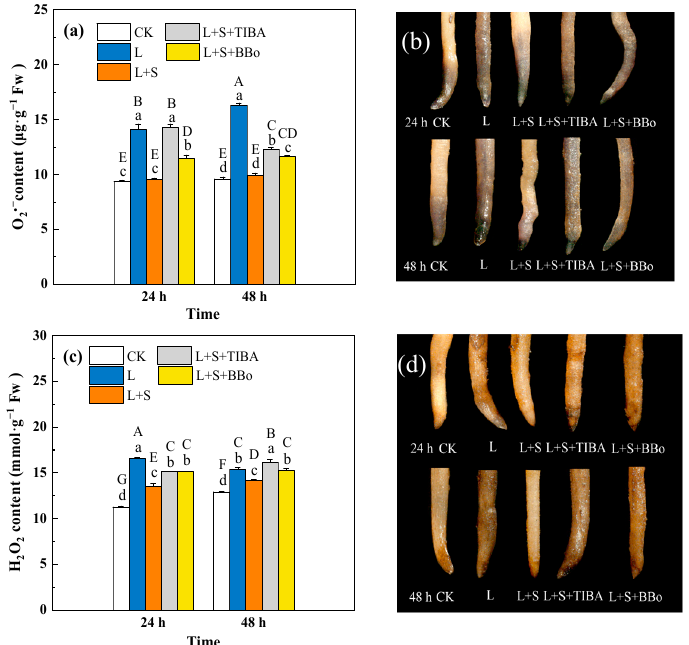
Figure 4. Effects of exogenous sucrose and IAA inhibitors on O 2. − ( a ) and H 2 O 2 ( c ) contents and histochemical staining ( b , d ) of M. baccata roots under sub-low temperature. Bars indicate means ± standard error ( n = 3). The lowercase letters represent significant differences between treatments ( p < 0.05). The capital letters represent significant differences between full data ( p < 0.05). The comparison of means is based on the Duncan’s multiple range test. CK, control treatment; L, sub-low root-zone temperature (5 ◦ C); L + S, 5 ◦ C + 90 mmol · L − 1 sucrose; L + S + TIBA, 5 ◦ C + 90 mmol · L − 1 sucrose + 500 µ mol · L − 1 2,3,5-triiodobenzoic acid; L + S + BBo, 5 ◦ C + 90 mmol · L − 1 sucrose + 300 µ mol · L − 1 4-biphenylboronic acid. (See Supplementary Materials).